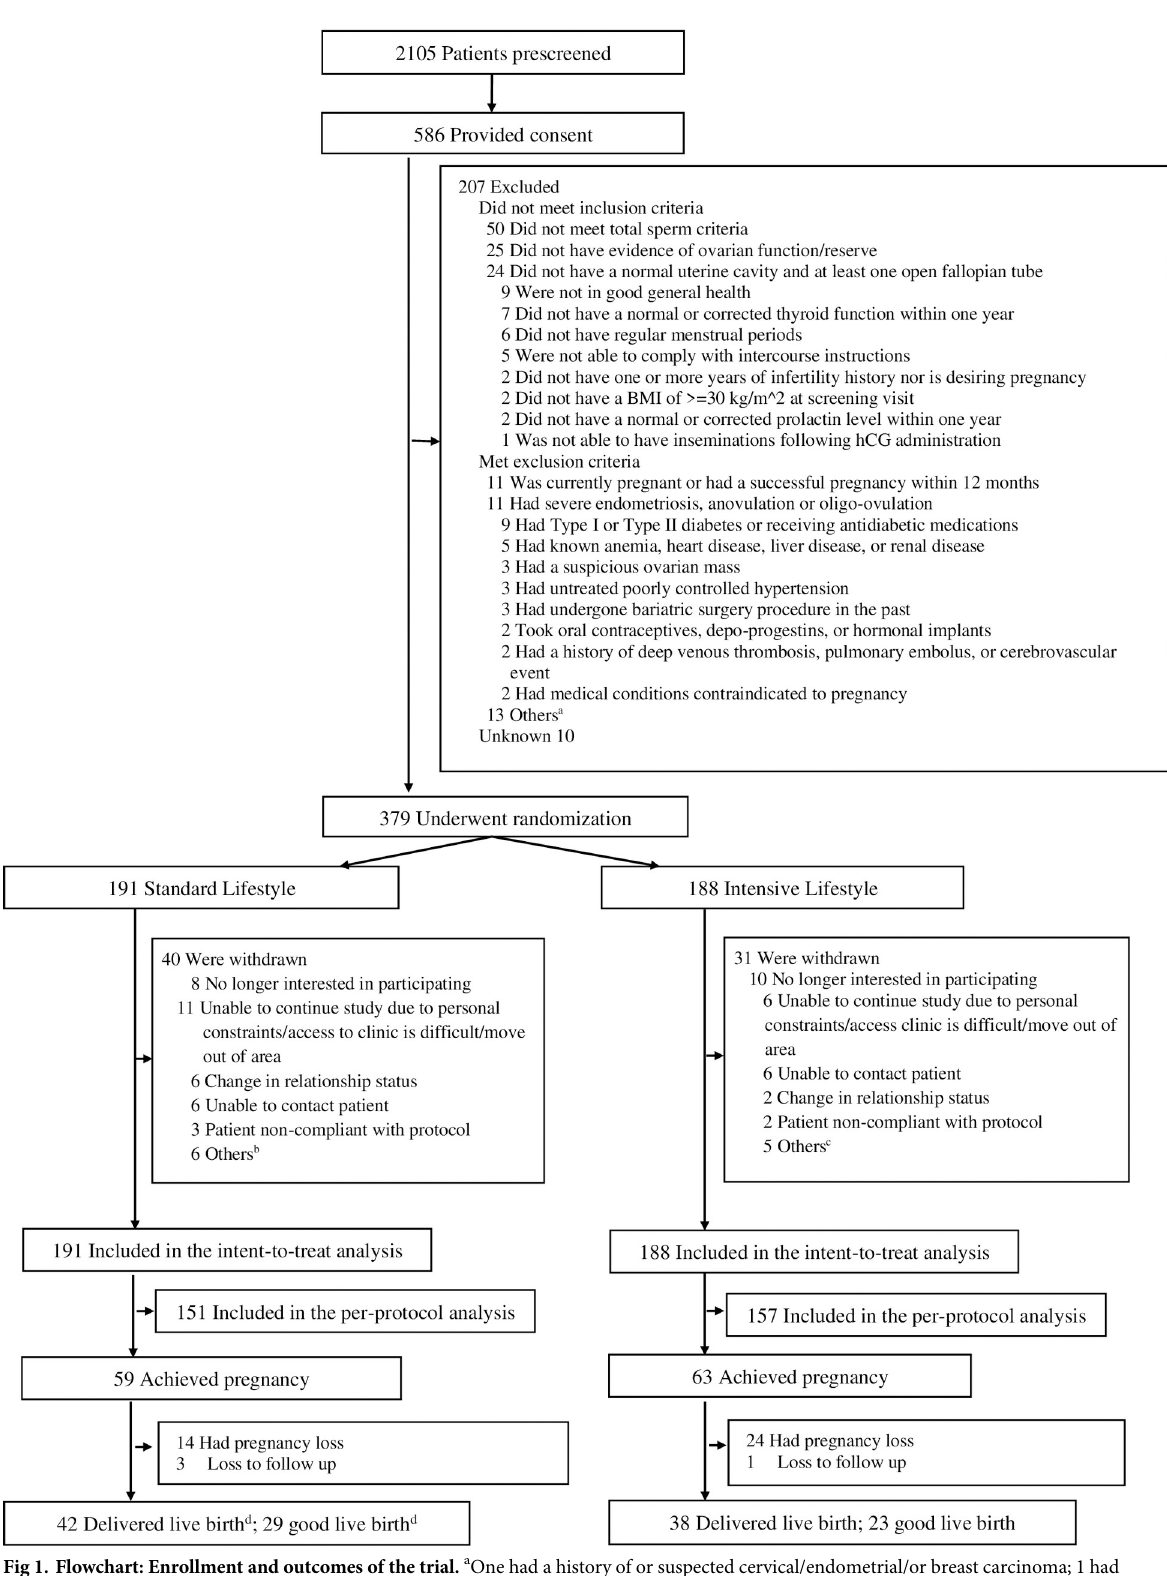
PLOS Medicine| https://doi.org/10.1371/journal.pmed.1003883 January 18,